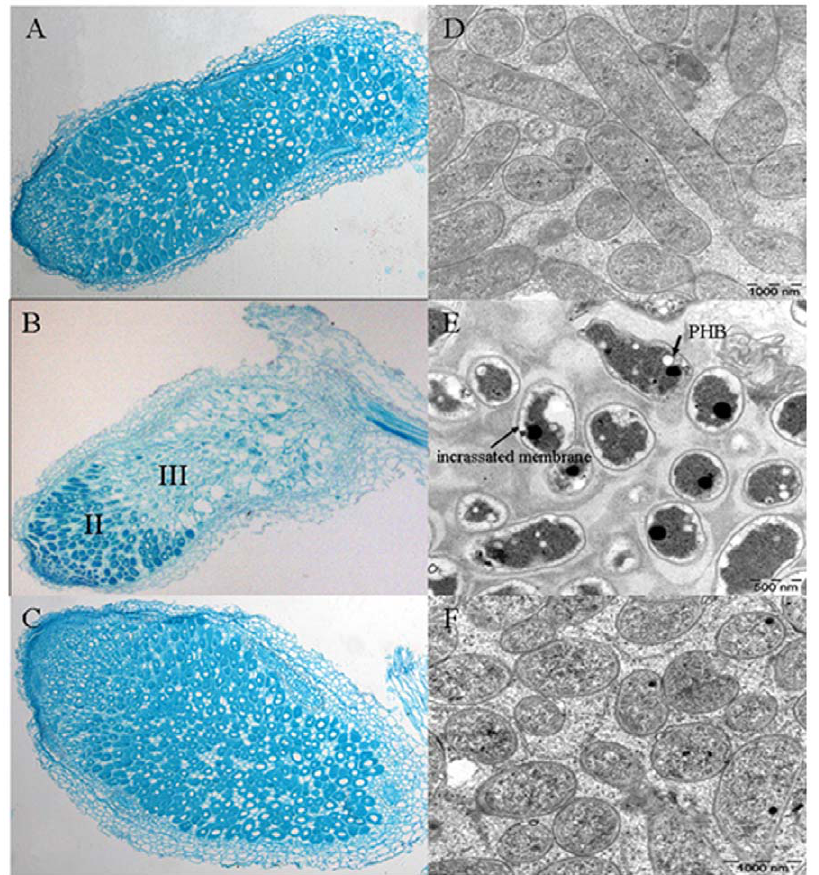
Figure 3. Paraffin section and ultrastructure observations of 5-week-old nodules formed by wild type strain 7653R, disruptant HK116, and complemented strain HK116C. (A) Paraffin section of normal nitrogen-fixation nodules formed by wild type strain 7653R. (B) Paraffin section of nodules induced by disruptant HK116 strains in which the dmtH gene was disrupted and nitrogen-fixation ability lost; bacteroids are mainly located in II zone. (C) Paraffin section of nodules induced by the complemented strain HK116C with restored nitrogen-fixation ability. (D) Ultrastructure of normal bacteroids in nodules induced by wild-type 7653R. (E) Ultrastructure of aberrant bacteroids in nodules induced by disruptant HK116, with smaller size, incrassated membrane, and visible PHB granules in bacteroid cells. (F) Ultrastructure of function-restored bacteroids in nodules induced by the complemented strain HK116C.